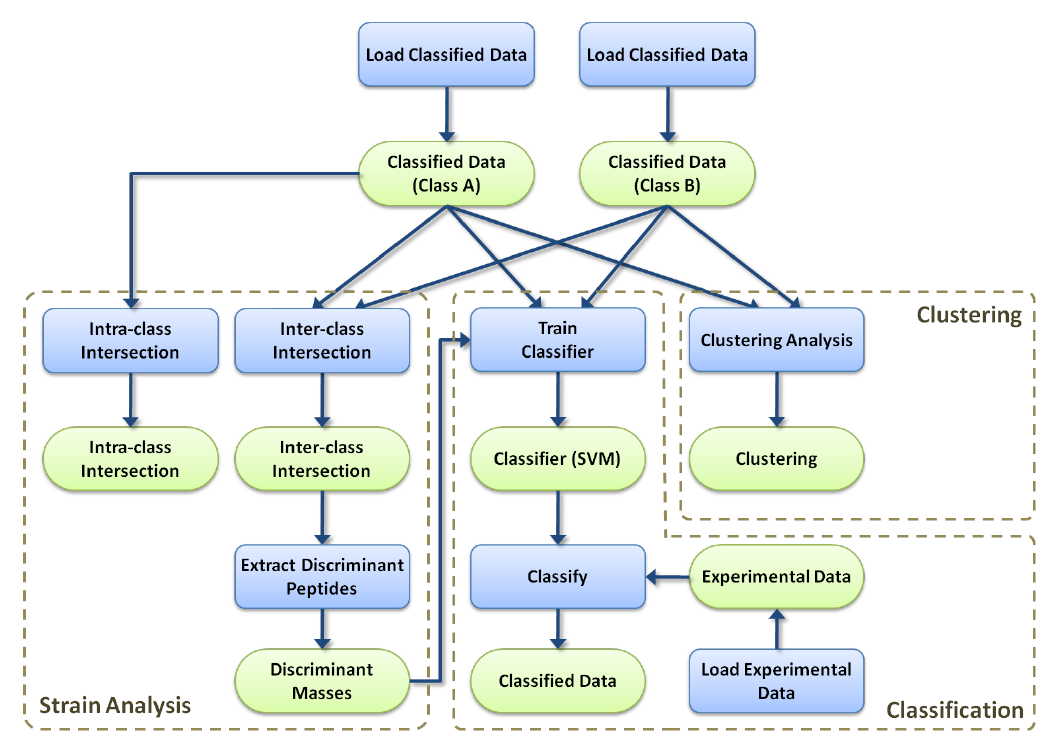
Figure 9: Bacterial Identification